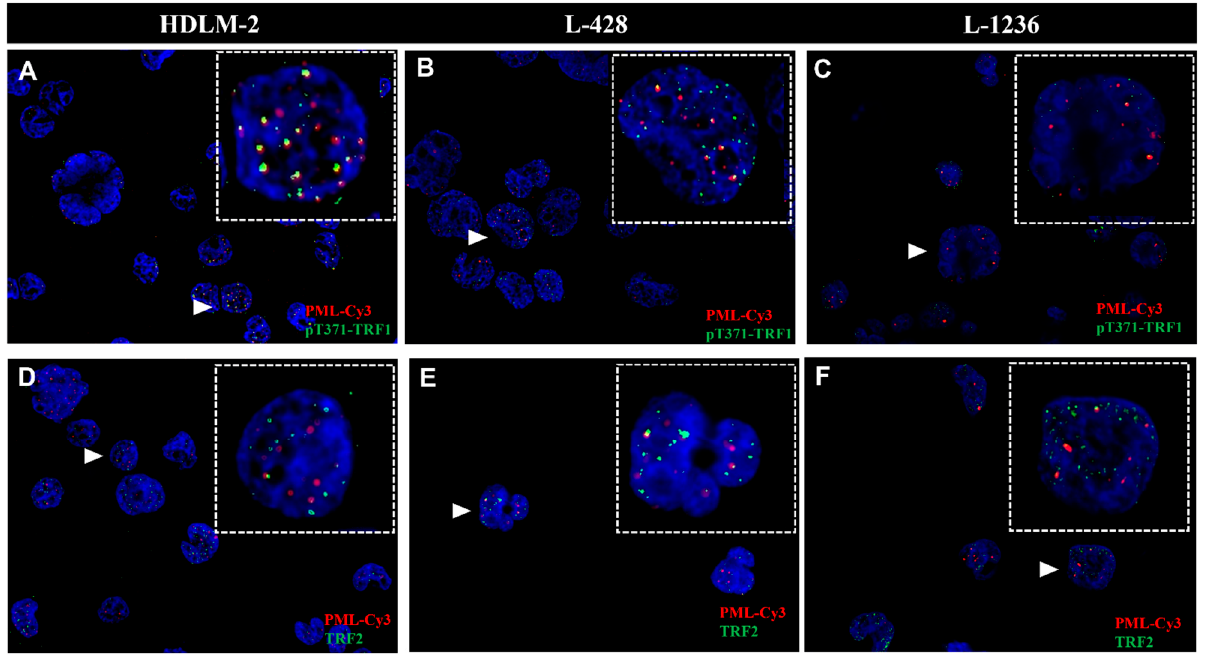
Figure A2 . Hodgkin’s Lymphoma shows ALT activation hallmarks. Analysis of colocalization of PML bodies, pT371-TRF1 and TRF2 in Hodgkin’s Lymphoma cell lines (HDLM-2, L-428 and, L-1236). ( A ) Analysis of colocalization of PML bodies and pT371-TRF1 in HDLM-2. A white arrow shows the zoomed cell. ( B ) Analysis of colocalization of PML bodies and pT371-TRF1 in L-248. A white arrow shows the zoomed cell. ( C ) Analysis of colocalization of PML bodies and pT371-TRF1 in L-1236. A white arrow shows the zoomed cell. ( D ) Analysis of colocalization of PML bodies and TRF2 in HDLM-2. A white arrow shows the zoomed cell. ( E ) Analysis of colocalization of PML bodies and TRF2 in L-428. A white arrow shows the zoomed cell. ( F ) Analysis of colocalization of PML bodies and TRF2 in L-1236. A white arrow shows the zoomed cell. Colocalized signals are shown in yellow. PML (Cy3-Red). pT371-TRF1 (FIT C-Green). TRF2 (FITC-Green). 90 cells were examined in three independent experiments and for each cell line. All cell lines display colocalization of pT371-TRF1 with PML and TRF2 with PML. However not all signals in each cell colocalize.